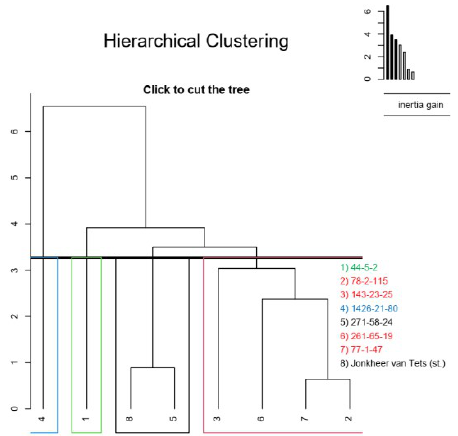
Figure 8. Hierarchical cluster analysis of red currant genotypes.